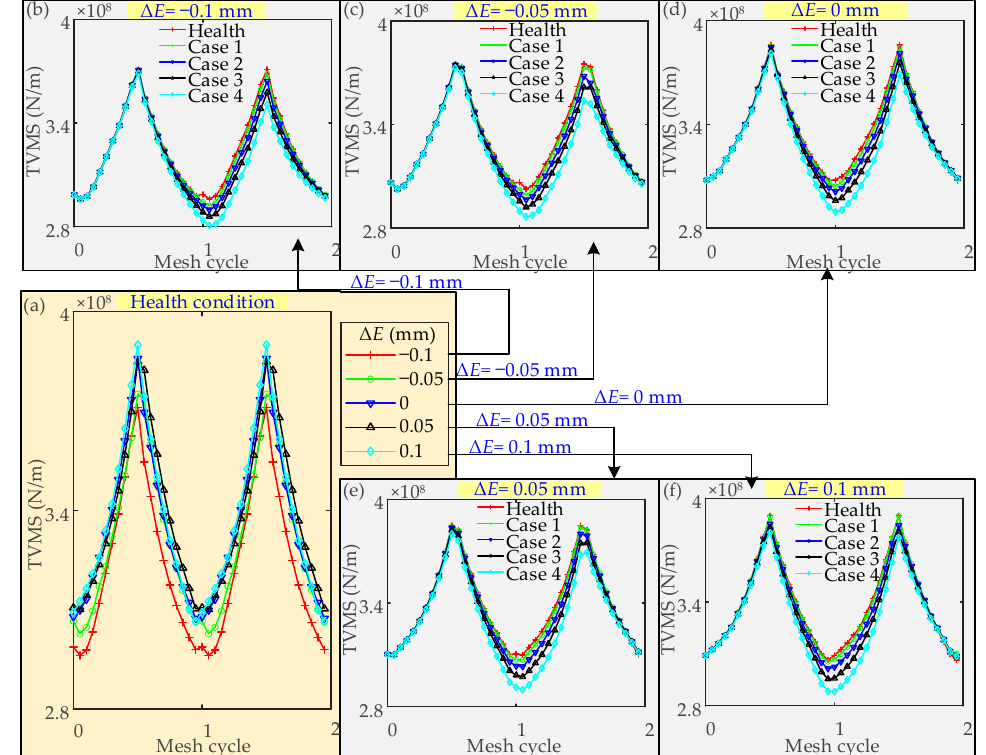
Figure 22. TVMS curves of SBGP considering assembly errors and crack faults: ( a ) TVMS in health conditions with offset errors; ( b ) TVMS curves in the condition of Δ E = − 0.1 mm with different crack degrees; ( c ) TVMS curves in the condition of Δ E = − 0.05 mm with different crack degrees; ( d ) TVMS curves in the condition of Δ E = 0 mm with different crack degrees; ( e ) TVMS curves in the condition of Δ E = 0.05 mm with different crack degrees; ( f ) TVMS curves in the condition of Δ E = 0.1 mm with different crack degrees.